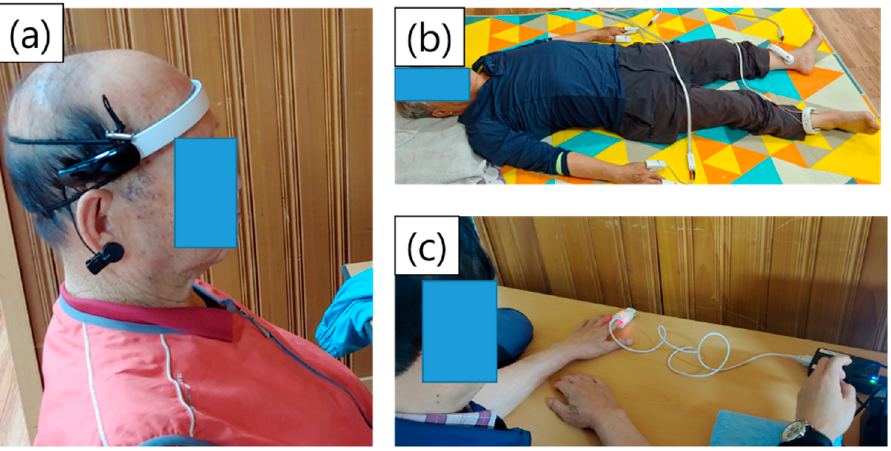
Figure 1. Photographs of the ( a ) electroencephalogram (EEG), ( b ) bioimpedance, and ( c ) photoplethysmography (PPG) measurement process.